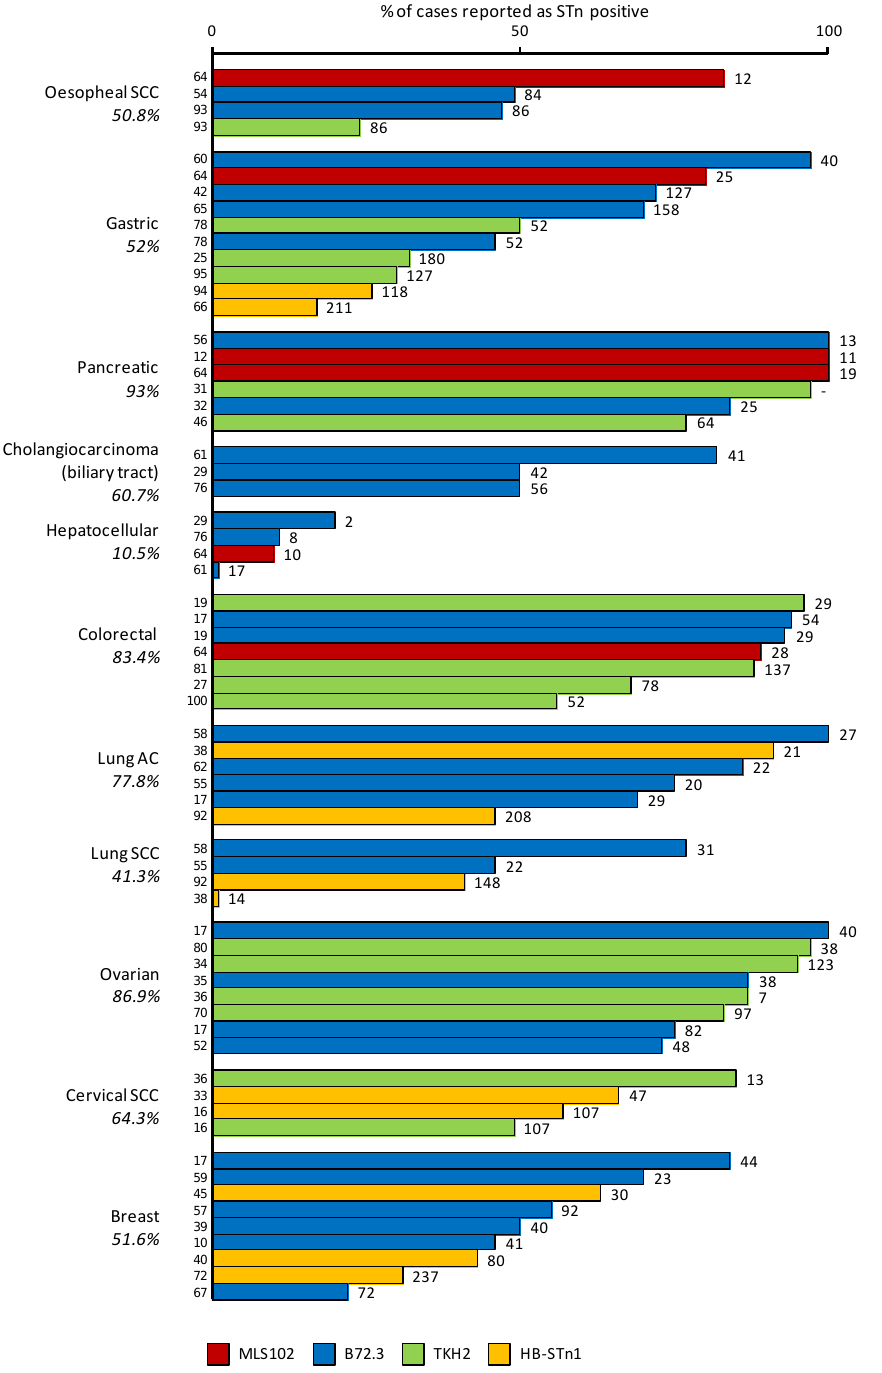
the base of each bar, including [56–62] that are not quoted elsewhere in the text. SCC: Squamous cell carcinoma, AC: